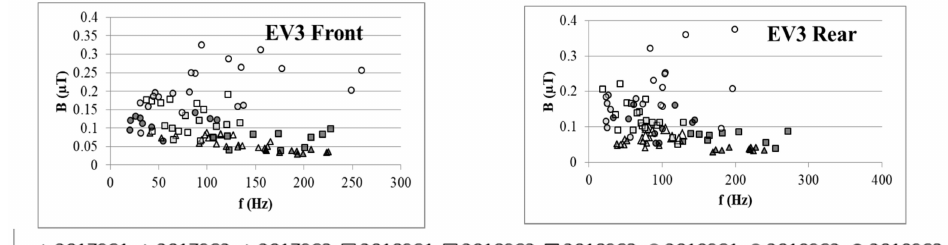
Figure 4. Measured SCs from the constant-driving modes at rear and front sets. The signs in the caption are formed of four digits representing the measurement year and three digits representing the specific SC, e.g., 2019SC3 indicating the third highest spectral component from the measurement in